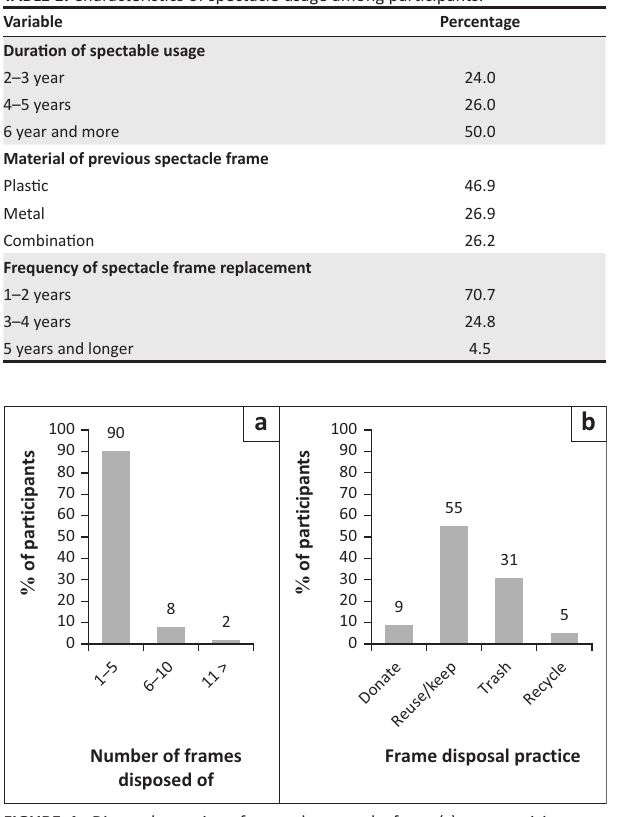
FIGURE 1: Disposal practices for used spectacle frame(s) per participant as determined in the questionnaire survey (a) Number of frames disposed of, (b) Frame disposal practice. TABLE 2: Concentration (mg/g) of main elements isolated from metal frames using inductively coupled plasma optical emission spectroscopy. Variable